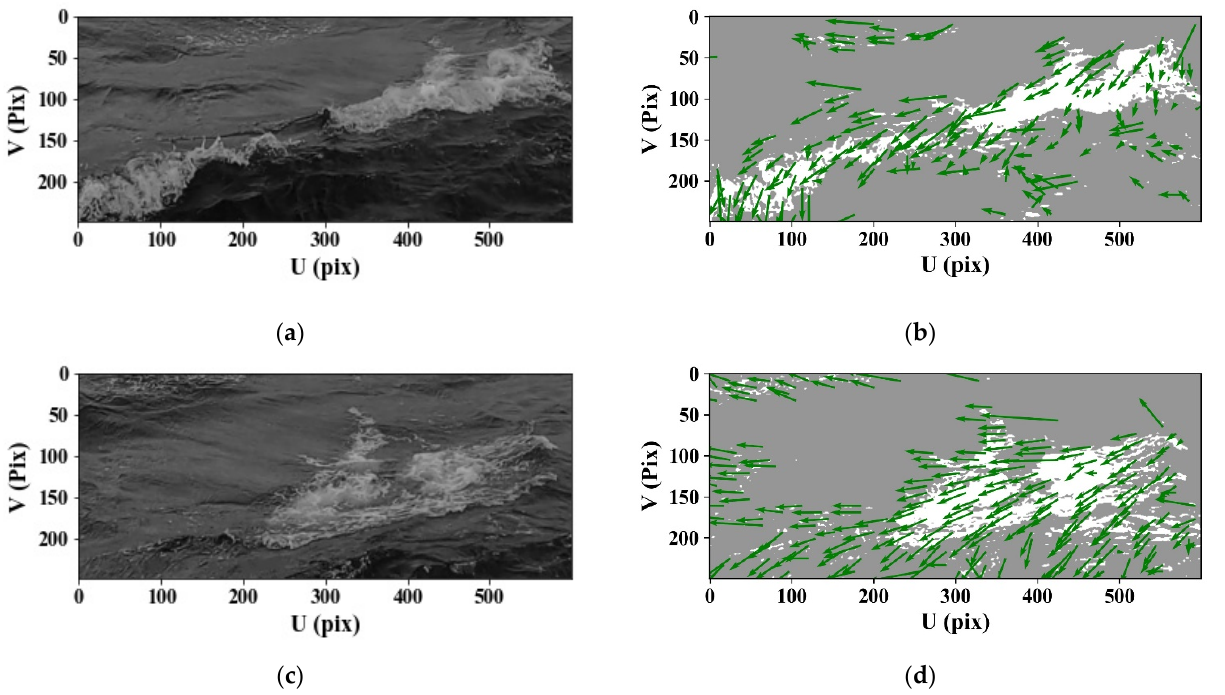
Figure 6. ( a ) An active whitecap in a visible image; ( b ) PIV result of the whitecap in the left panel; ( c ) a residual whitecap in a visible image; ( d ) PIV result of the whitecap in the left panel.